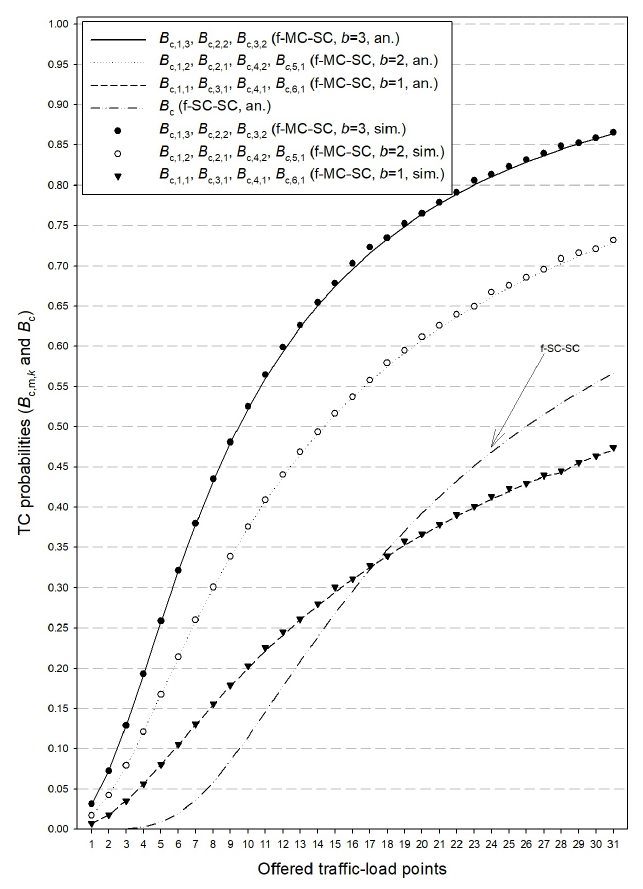
Figure 3. TC probabilities due to lack of